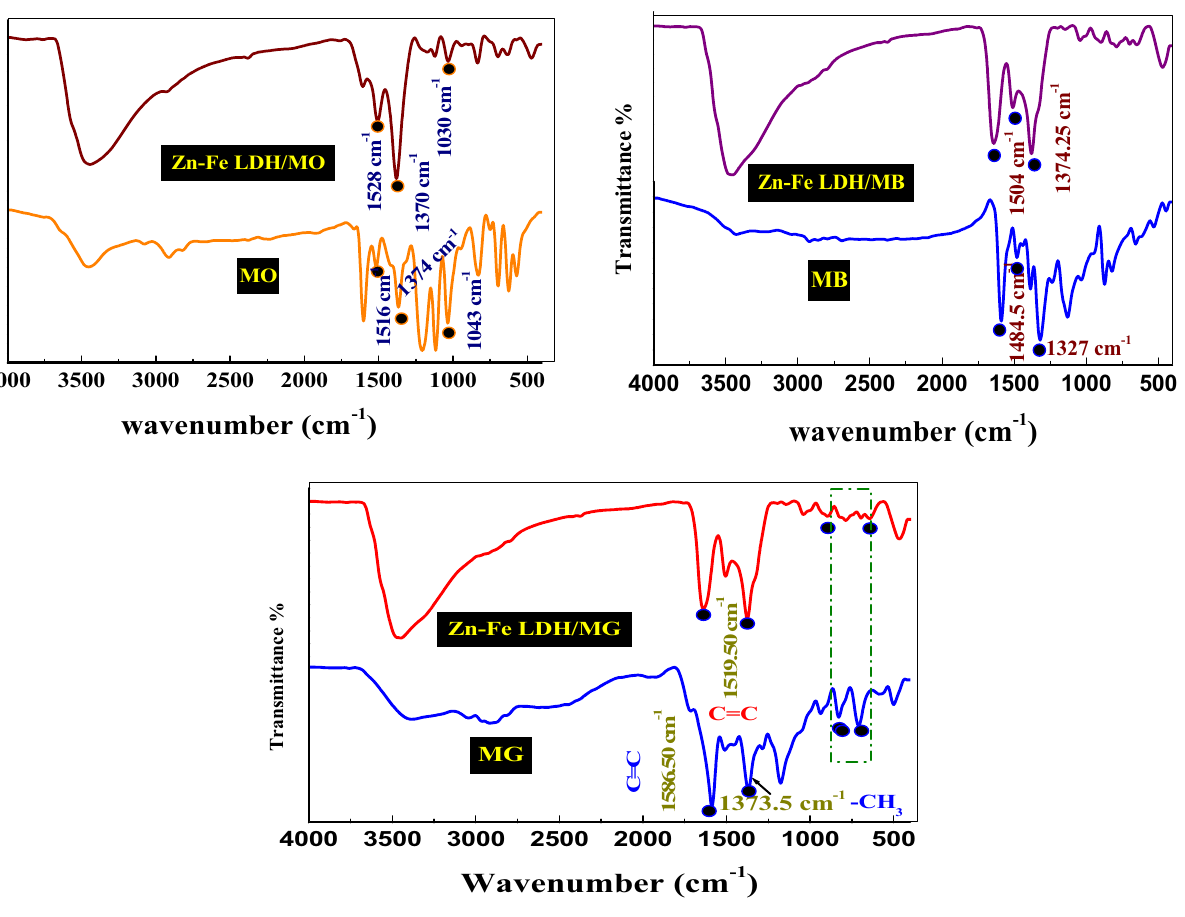
Figure 13. The FT-IR spectra of Zn–Fe LDH samples before and after adsorption of MG, MB, and MO